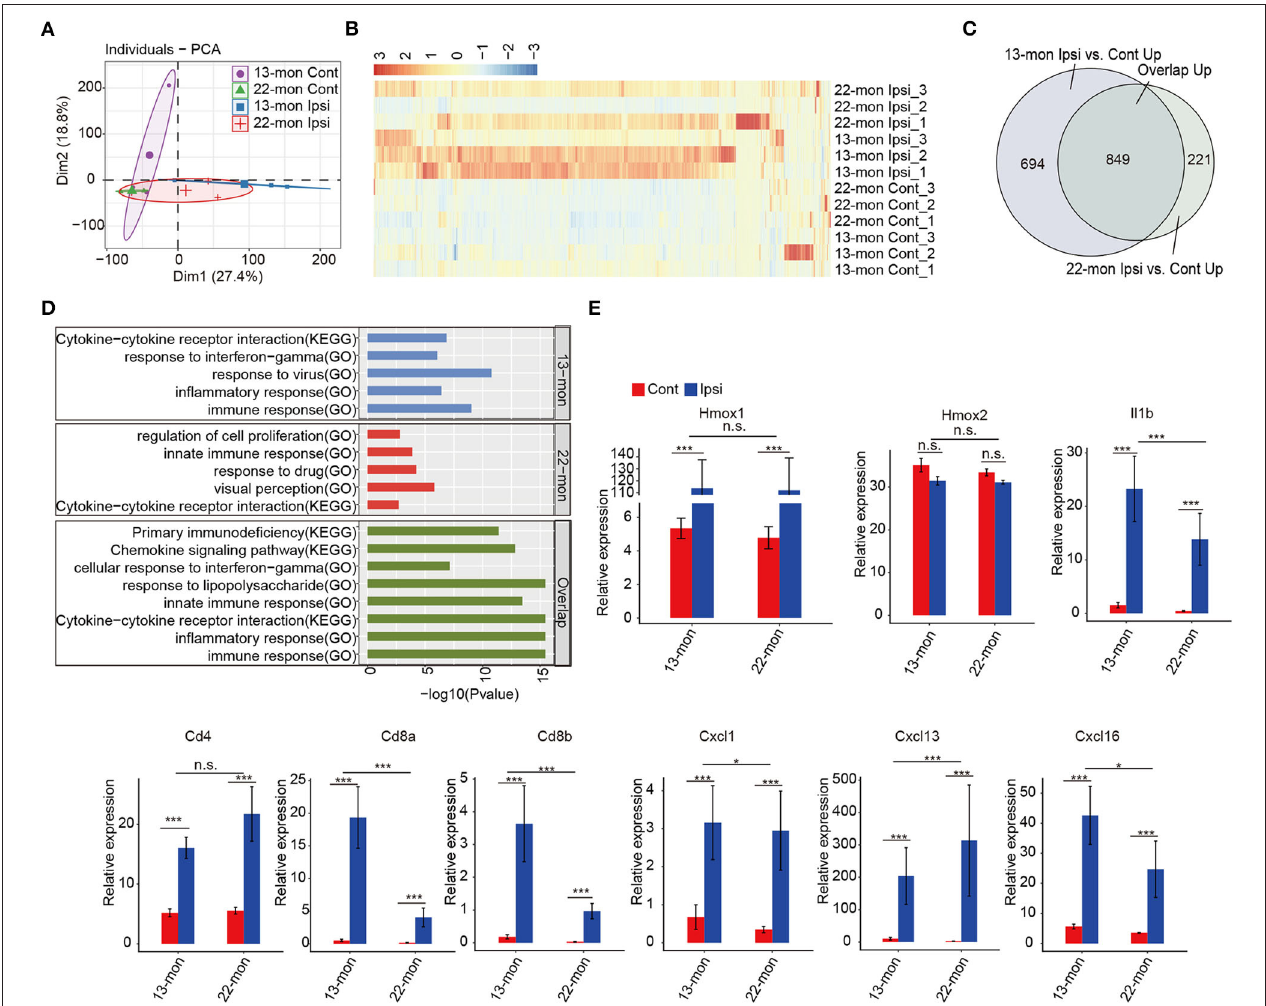
FIGURE 2 | Enrichment of inflammation and immune response-associated genes in ICH-induced acute brain injury of aging ICH rats. (A) Principal component analysis shows distinct divergence between the ipsilateral and contralateral brain tissues of RNA-seq samples. (B) Hierarchical clustering heat map showed the dominant upregulation of differentially expressed genes (DEGs) between the ipsilateral and contralateral brain tissues of aging rats 3 days after ICH surgery. (C) Venn diagram shows the highly overlapped, upregulated DEGs between 13- and 22-month-old ICH rats. (D) Bar plot shows the top enriched GO terms and KEGG pathways of specifically upregulated DEGs in 13-month-old (top panel) and 22-month-old ICH rats (middle panel), and overlapped, upregulated DEGs between 13- and 22-month-old rats (bottom panel). (E) Bar plot shows the expression levels of genes related to the inflammatory response. The bar graphs show the mean ± SEM; p -value was determined by using the Student’s t -test. * p < 0.05 and *** p < 0.001,